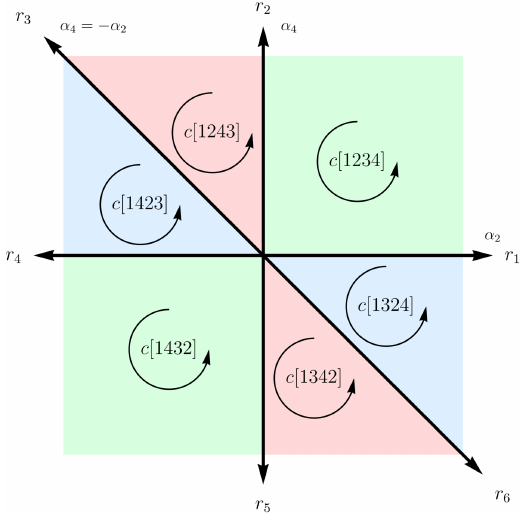
Figure 5 . Positive sectors corresponding to four-particle MHV amplitudes for each